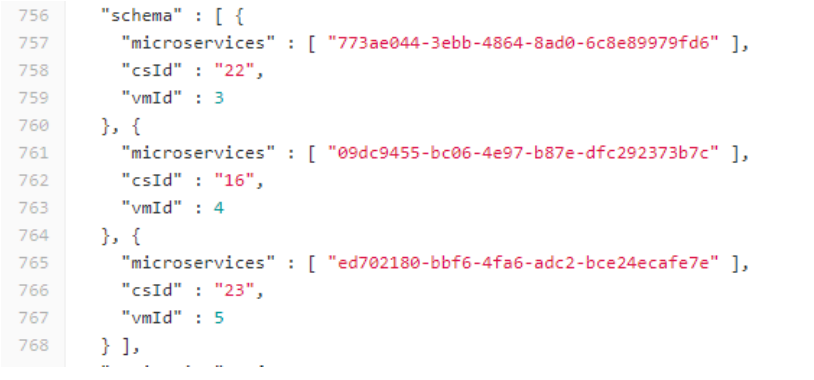
Figure 9. Snippet of the application description JSON file, where the best combination of infrastruc- tural elements are suggested in through the “schema” element.